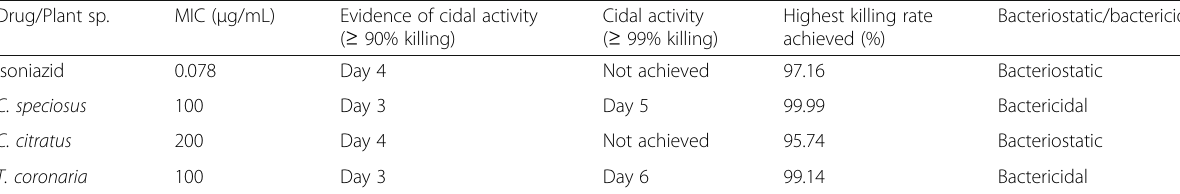
Table 4 Overall key effects of n-hexane plant partitions on the growth kinetics of Mycobacterium tuberculosis H37Rv Drug/Plant sp.